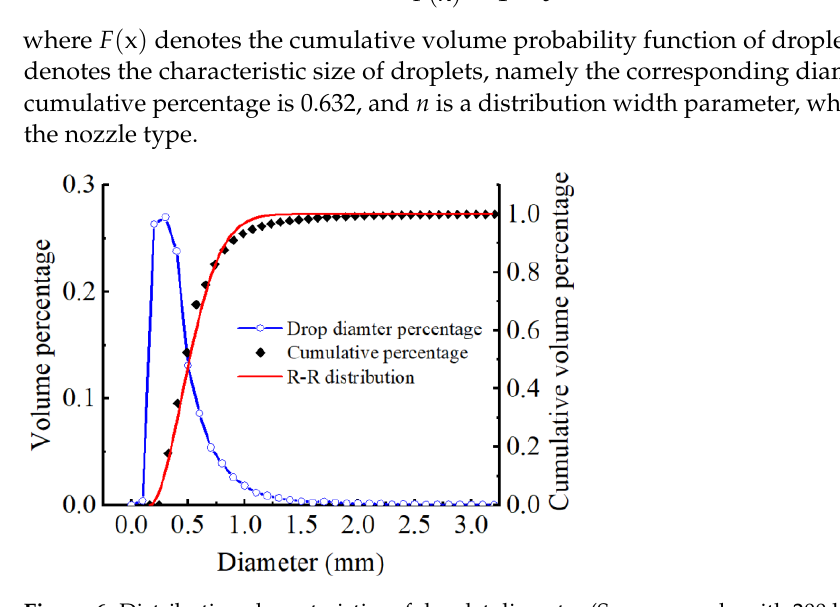
Table 3. Rosin – Rammler parameters of the droplet size distribution for different nozzles.